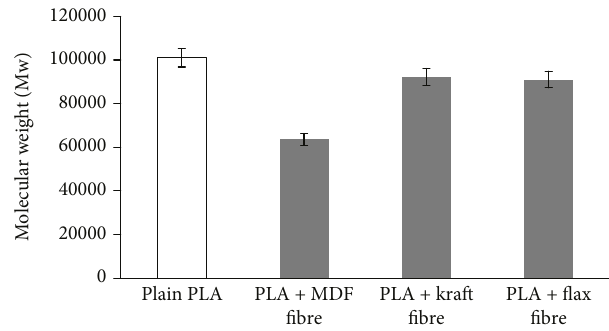
Figure 5: E ff ect of three natural fi bre types on PLA MW after extrusion and injection moulding (all fi bres at 30wt %) (error bars = ± 95% con fi dence interval).